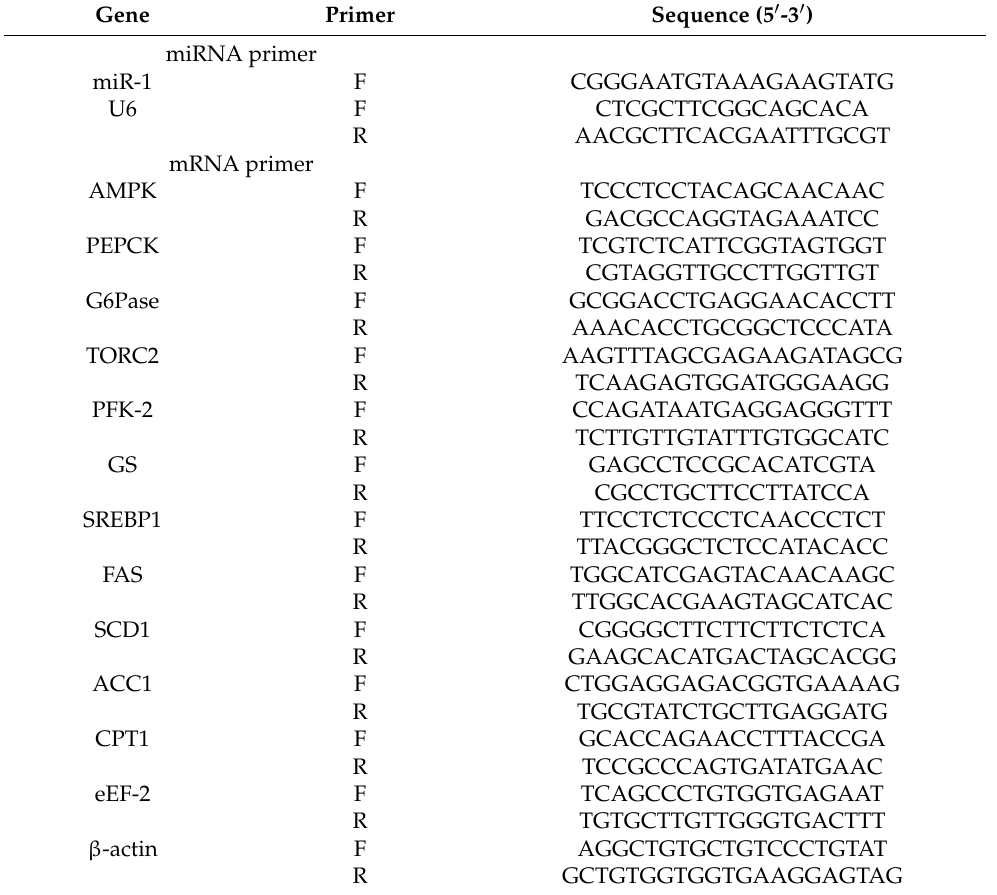
Table 1. Primers and sequences referred in the experiments. Gene Primer Sequence (5 (cid:48) -3 (cid:48) ) miRNA primer miR-1 F